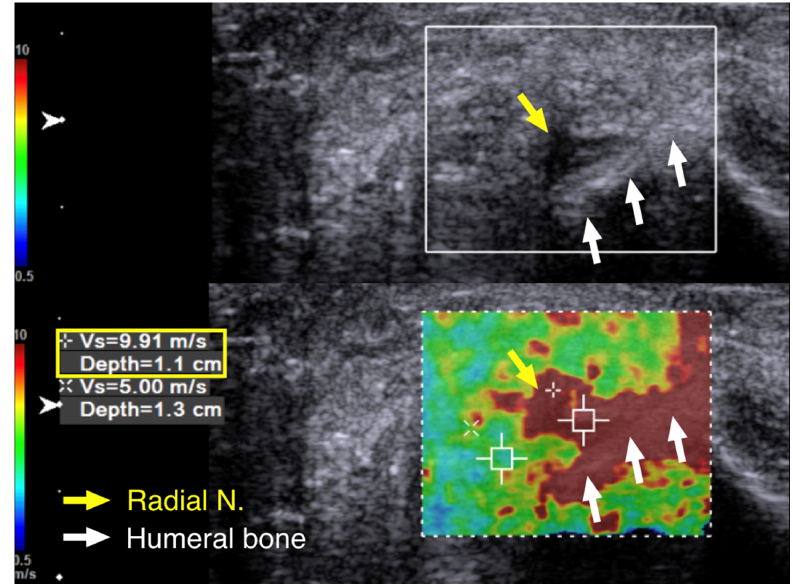
5 Figure 5. Case 2: Shear wave velocity at the spiral groove level. A 43-year-old man with radial nerve palsy after plating of a left humeral shaft fracture. Cross-sectional ultrasound imaging of the radial nerve with shear wave elastography, with a shear wave velocity of 9.91 m / s. Yellow arrow and box: radial nerve in cross -sectional view. White arrow: humeral